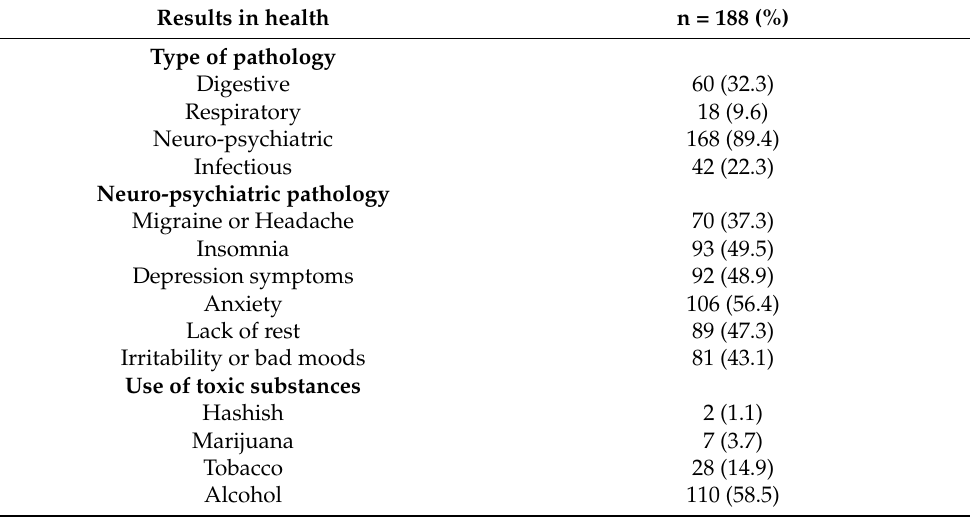
Table 2. Results in